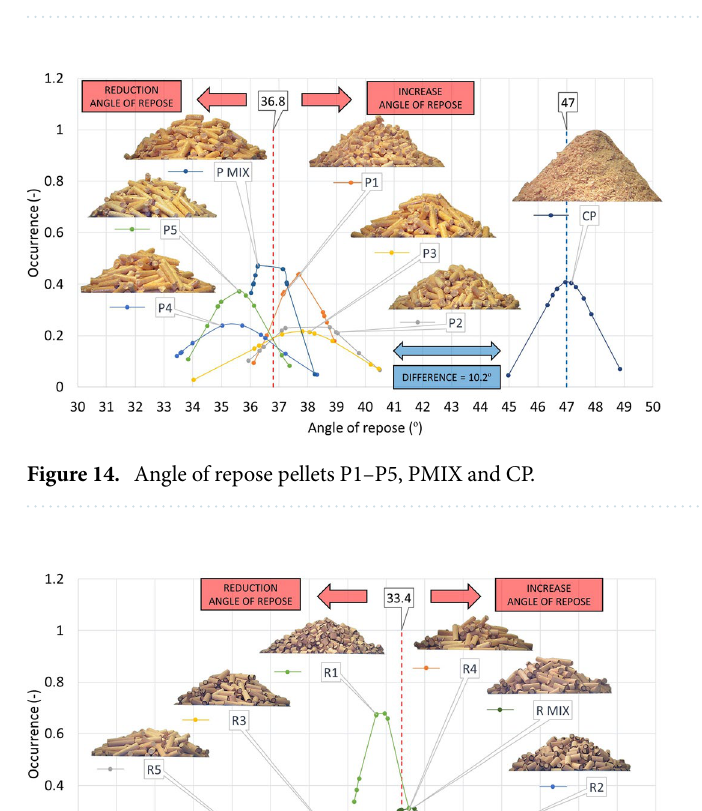
Table 6. Static AOR with standard deviation of measurement (σ sd ) and classification of flow properties.